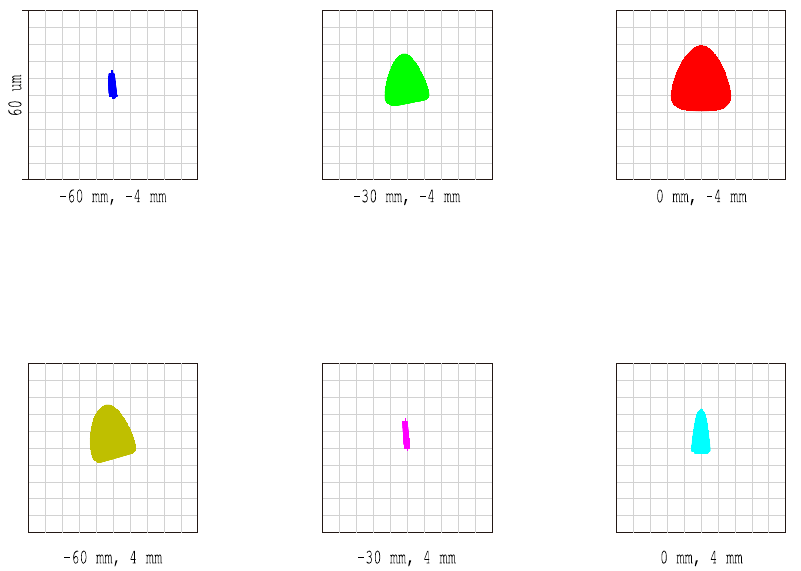
Figure 7. Spot diagrams of the LWIR imaging spectrometer for the fields (( − 60 mm, − 4 mm), ( − 30 mm, − 4 mm), (0 mm, − 4 mm), ( − 60 mm, 4 mm), ( − 30 mm, 4 mm), and (0 mm, 4 mm)) along the slit for the central wavelength of 10 µ m. The size of the scale box equals that of two detector pixels (60 µ m × 60 µ m).